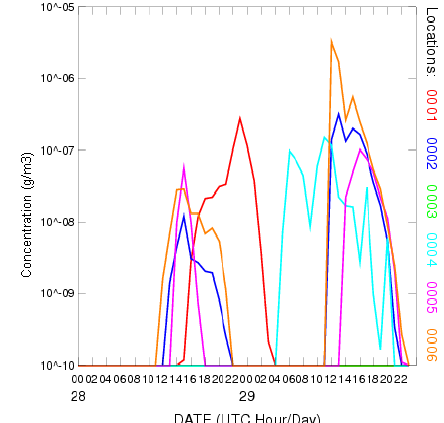
Figure 19 : Simulated SO2 concentration at 5 model grids corresponding to 1) Natchz, 2) Pascagoula 3) Cleveland